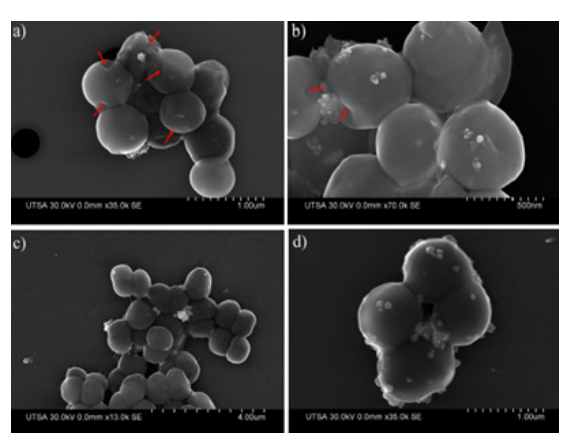
Figure 9: SEM images show cell size and morphology along with AgNPs interacting to the cell surface for (a) and (b) MRSA